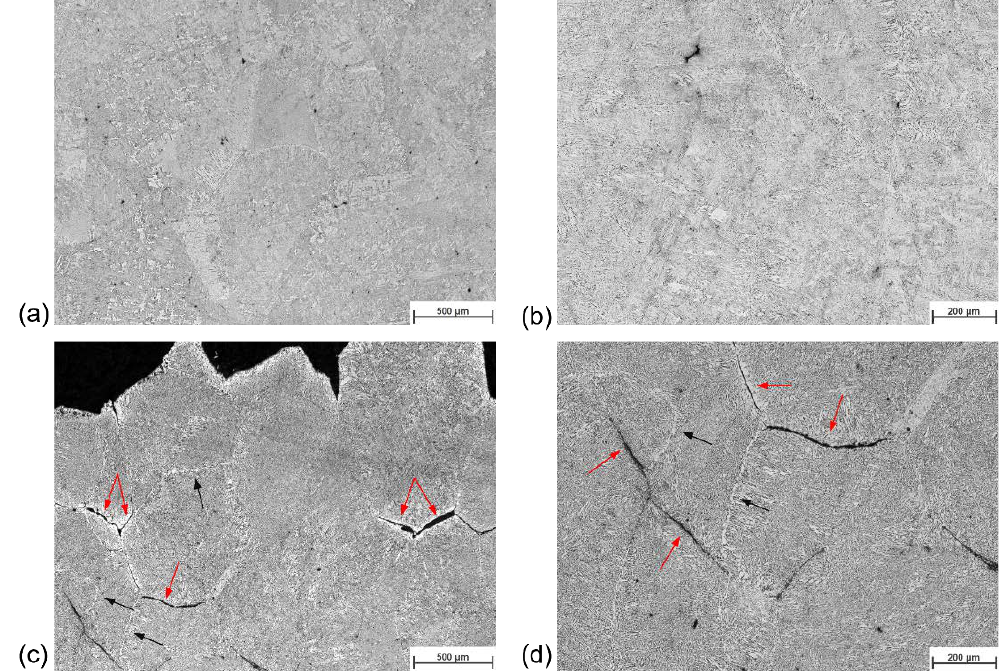
Figure 5. Microstructure images of the samples from steel A tested at 850 °C and ( a ) 10 −2 s −1 , 50×; ( b ) 10 −2 s −1 , 100×; ( c ) 10 −4 s −1 , 50×; and ( d ) 10 −4 s −1 , 100×. Black arrows indicate the ferrite films at the grain boundaries and the red arrows indicate the crack formation at the boundaries.